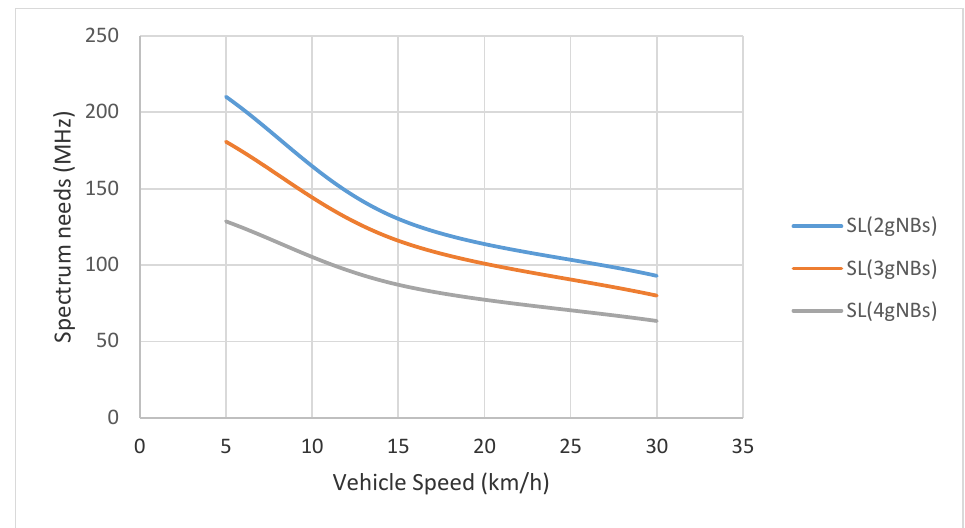
Figure 6. Sidelink (SL) spectrum needs per gNB sector in the urban grid environment.